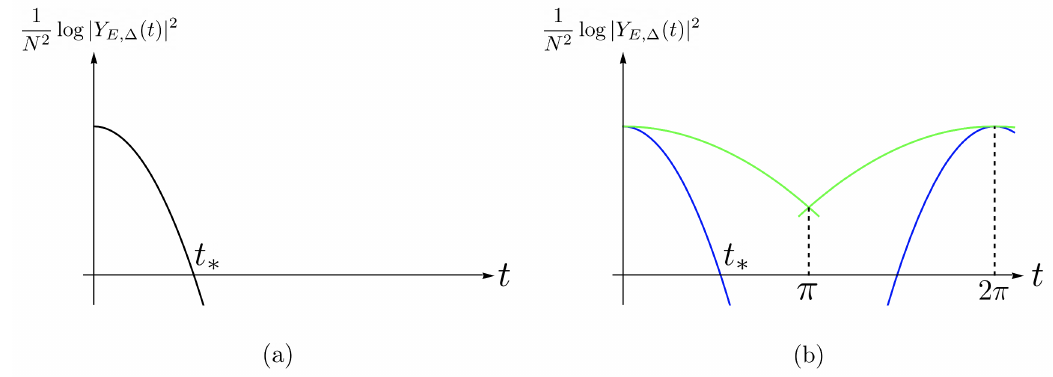
Figure 5 . (a) | Y E, ∆ ( t ) | 2 from the short time saddle. It decays to exponentially small at t ∗ ∼ O (1) . (b) If the single particle spectrum is evenly spaced (as in our first example (2.5)), there is another obvious saddle by shifting the short time one by the period. This could sometimes prevent | Y E, ∆ ( t ) | 2 from becoming exponentially small (see green curve), but not for large ∆ 2 (see blue